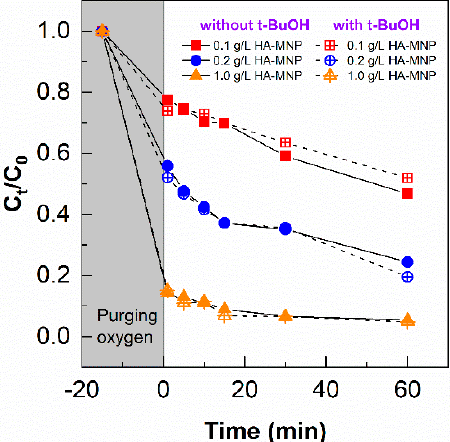
Figure 7. The removal of As(III) in the presence and absence of an •OH quencher during photo-irradiation for 60 min. [HA-MNP] = 0.1, 0.2, and 1.0 g L − 1 ; [As(III)] 0 = 200 µg L − 1 and [ t -BuOH] = 10 mM.